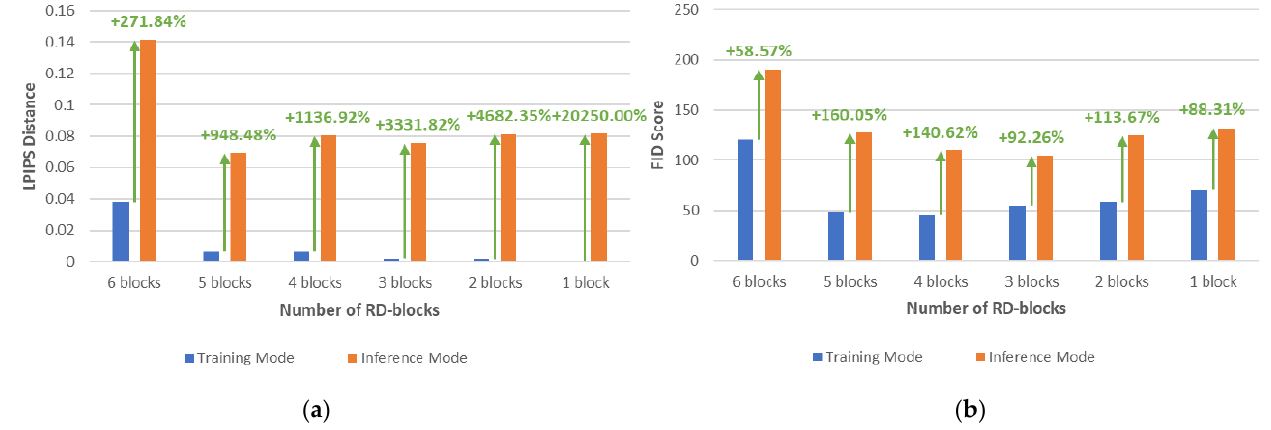
Figure 4. ( a ) LPIPS and ( b ) FID metrics of the synthetic images generated in training and inference modes. Despite the lowest percentage increase of 271.84% by the six RD-block variation, the model achieved the overall highest LPIPS distance of 0.1413, approximately two-fold higher than other variations. Figure 5 shows the perceptual difference output images generated in